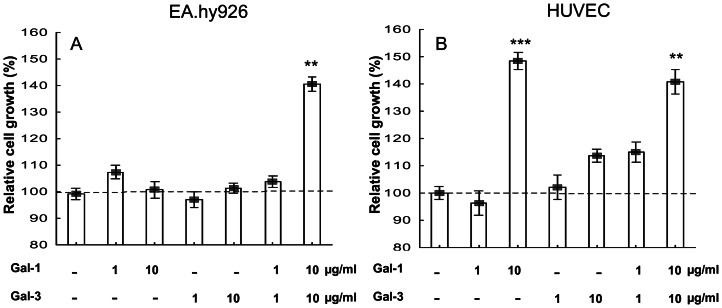
Modulation of cell growth by exogenous galectins.The effects of exogenous galectins on the growth of EA.hy926 (A) and HUVEC (B) cells were evaluated by the MTT assay. (A) The MTT conversion in EA.hy926 cells was measured one day after galectin stimulation at the indicated concentrations. (B) The MTT conversion in HUVECs was measured two days after galectin stimulation at the indicated concentrations. Each condition was tested with six replicates. The data (mean +/− SEM) are shown as relative values compared with the control (no galectin addition), and significant differences are indicated (* p<0.05, ** p<0.01 and *** p<0.001).